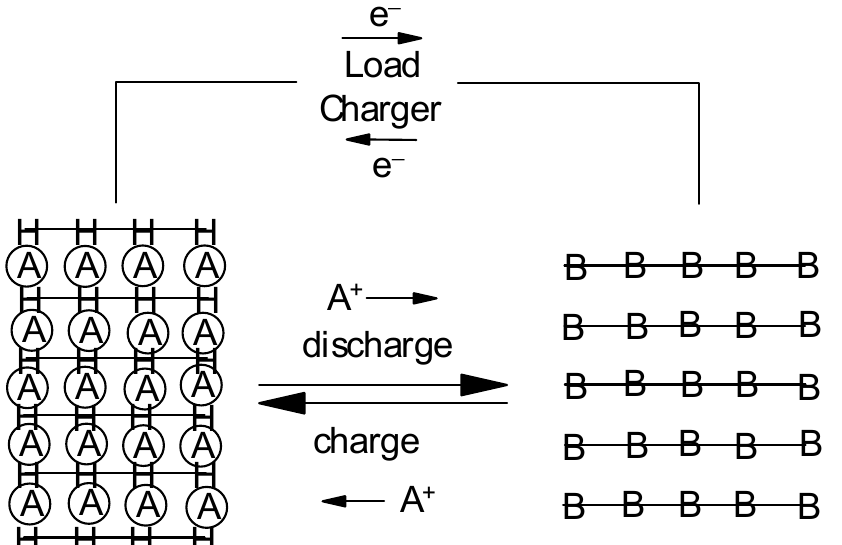
Figure 2. Principle of a rocking-chair battery, both negative (H) and positive (B) intercalation-type electrodes are assumed.